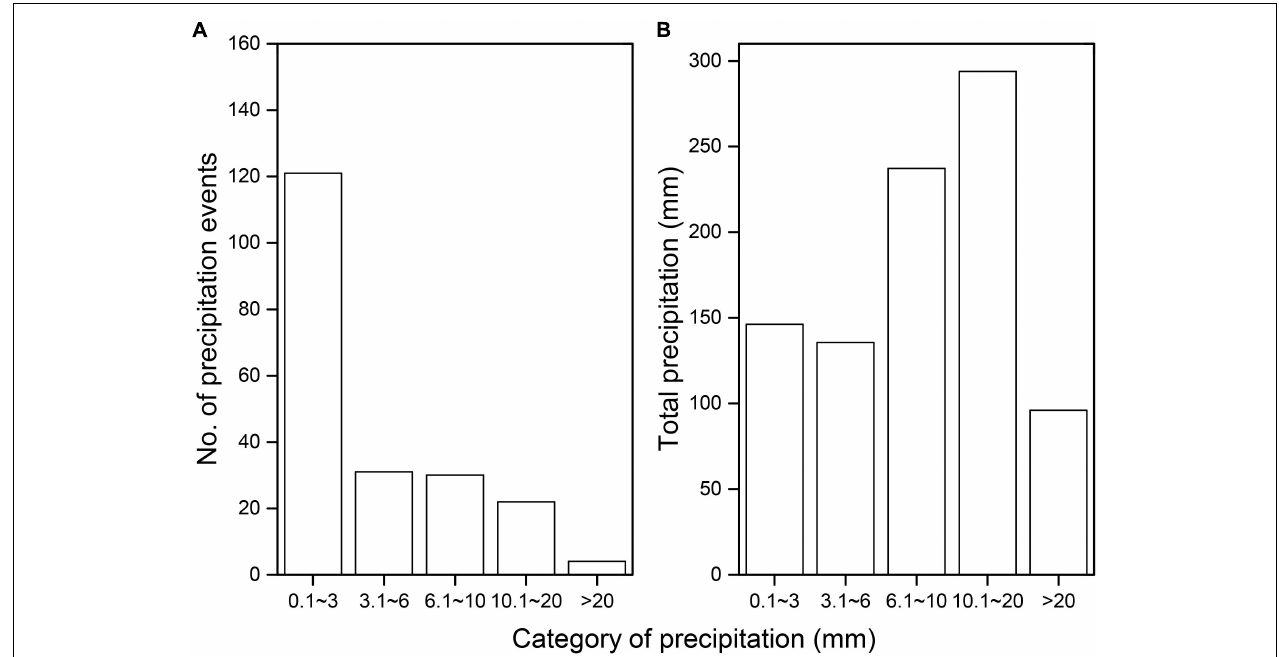
FIGURE 2 | Number of precipitation event (A) and total precipitation (B) amount across different category precipitation.